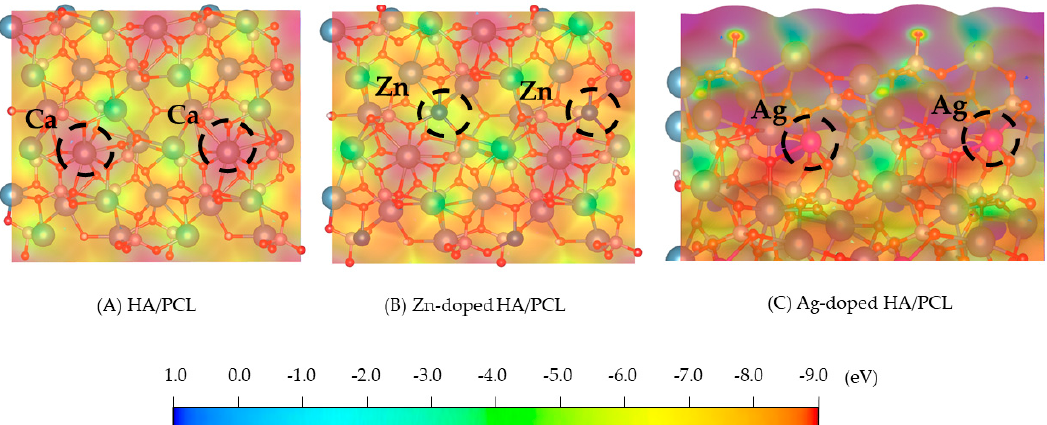
Figure 2. ESP of PCL on different surfaces of HA, Zn-doped HA, and Ag-doped HA.